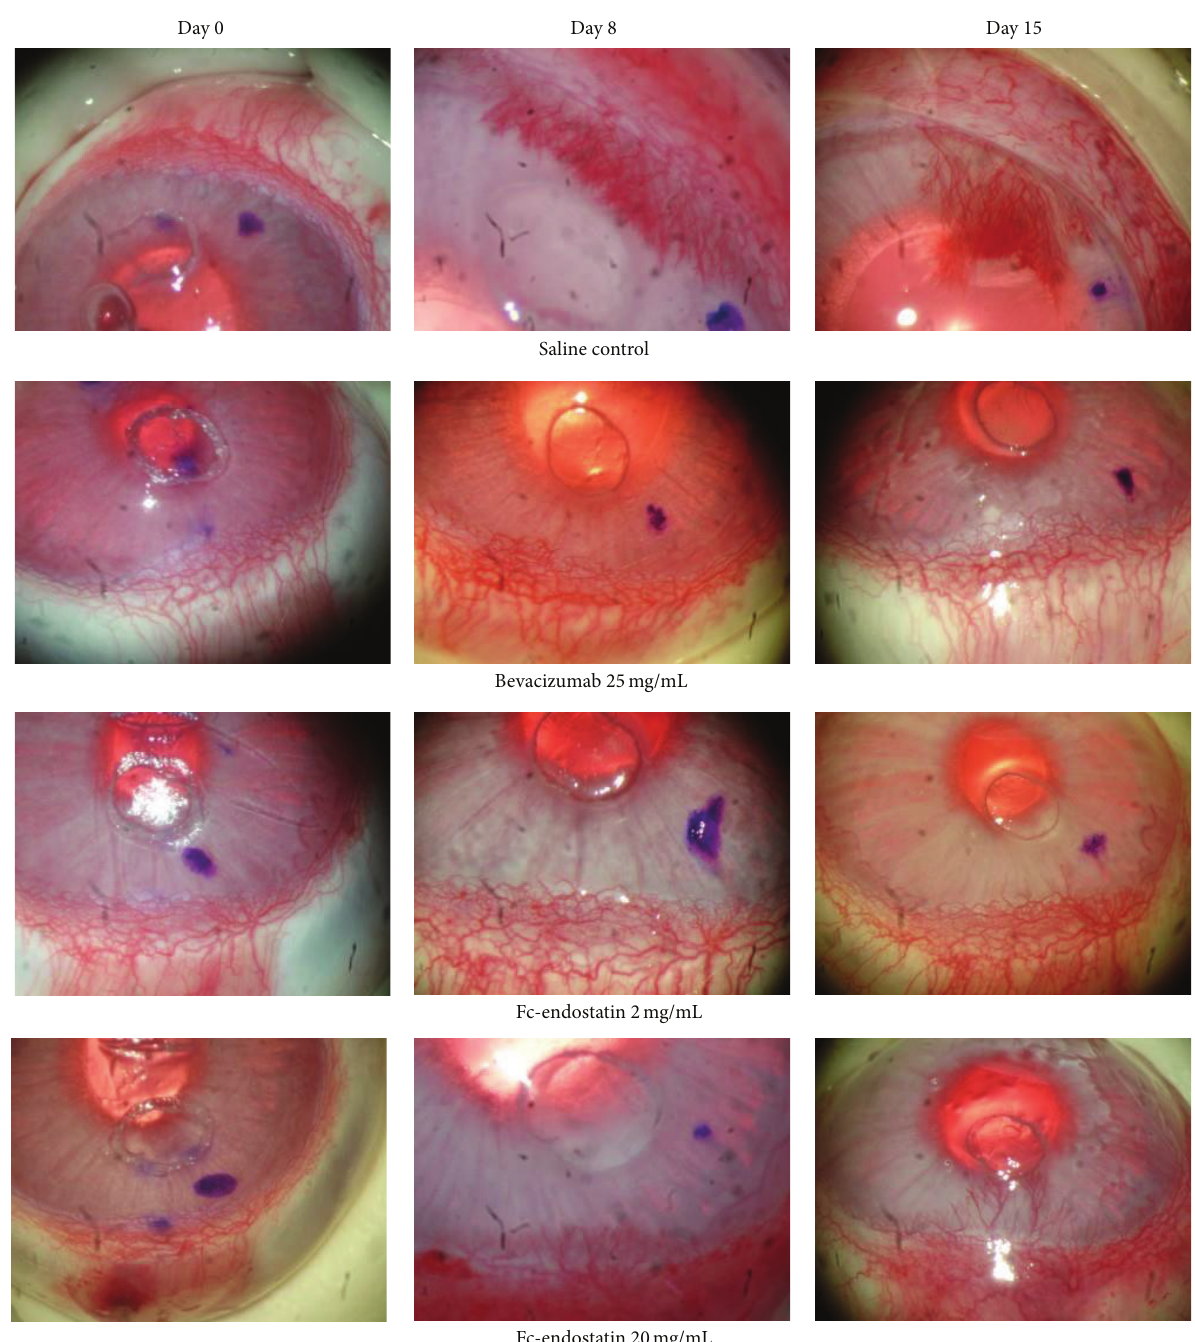
Figure 2: Representative photos of each treatment group on days 0, 8, and 15 after implantation of human vascular endothelial growth factor (VEGF) polymer within the corneal stroma micropocket. Treatment drugs were delivered via subconjunctival injection on days 0, 5, 8, 12, and 15. No statistical difference was noted between bevacizumab (BV) and Fc-endostatin 2mg/mL (FcE 2). BV was found to significantly decrease neovascularization when compared with Fc-endostatin 20 mg/mL (FcE 20) by day 8. FcE 2 was found to significantly decrease neovascularization compared with FcE 20 by day